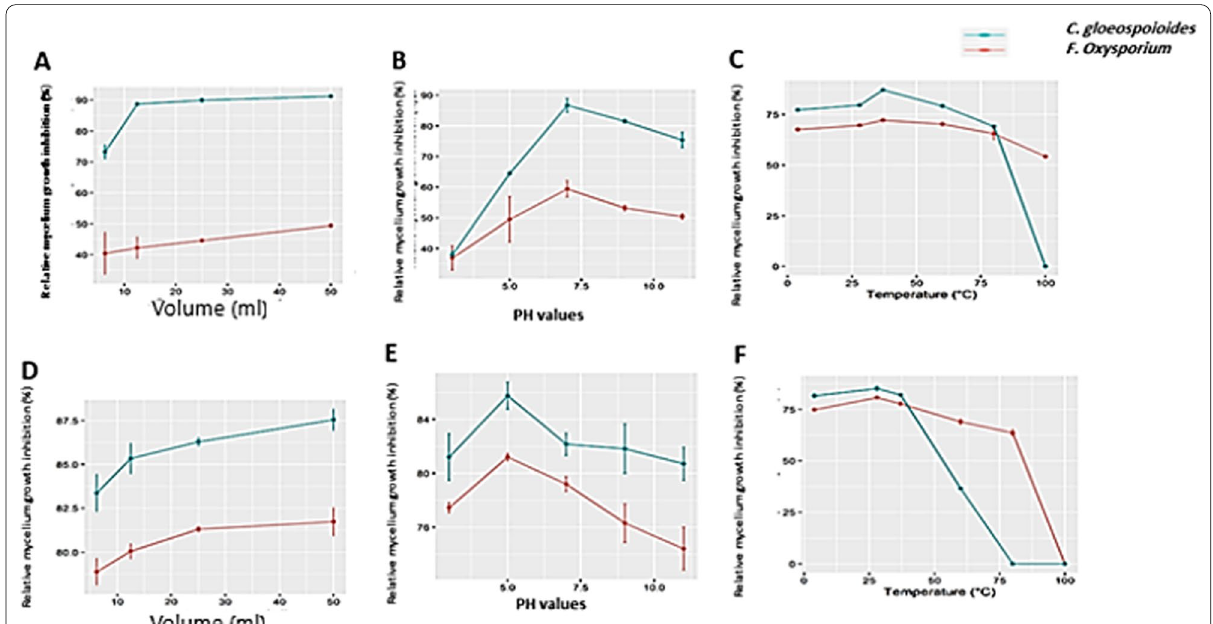
Fig. 4 Different key parameters affect the growth of phytopathogens. A Different cultural filtrate volumes, B pH values, and C different temperatures of Bacillus velezensis 33RB suspension affect the growth of phytopathogens. D – F Different cultural filtrate concentrations, pH values, and different temperatures of Aspergillus niger 46SF suspension affect the growth of